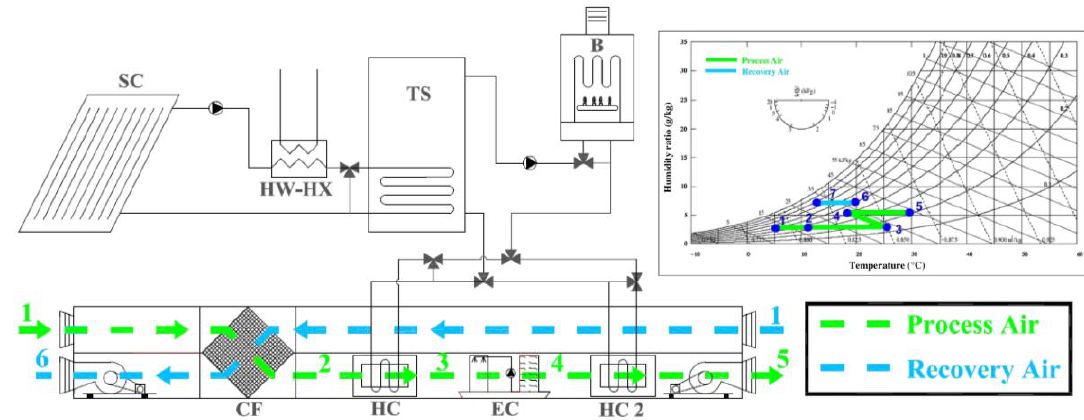
Figure 2. Scheme of the desiccant-based AHU and psychrometric diagram (heating mode, Scenarios A, B, C and D).